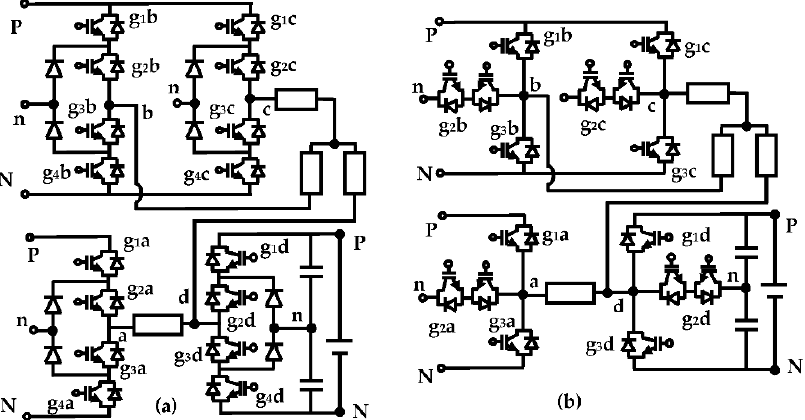
Figure 2. Dual-phase inverters with different inverter-legs; ( a ) 3-level diode-clamped; ( b ) T-type.